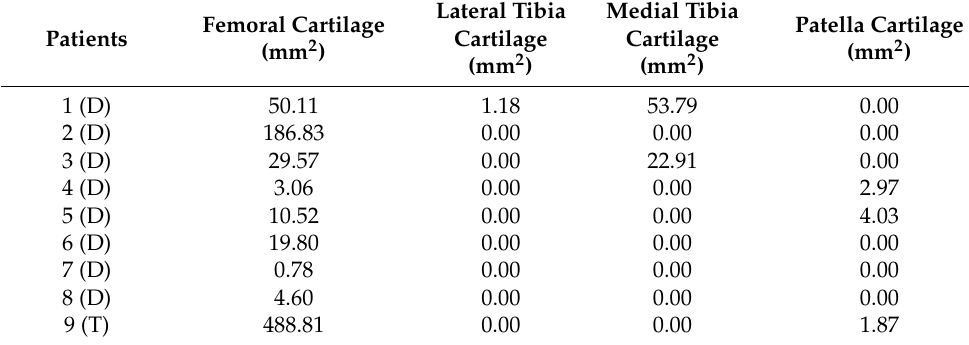
Table 3. Total hole surface.